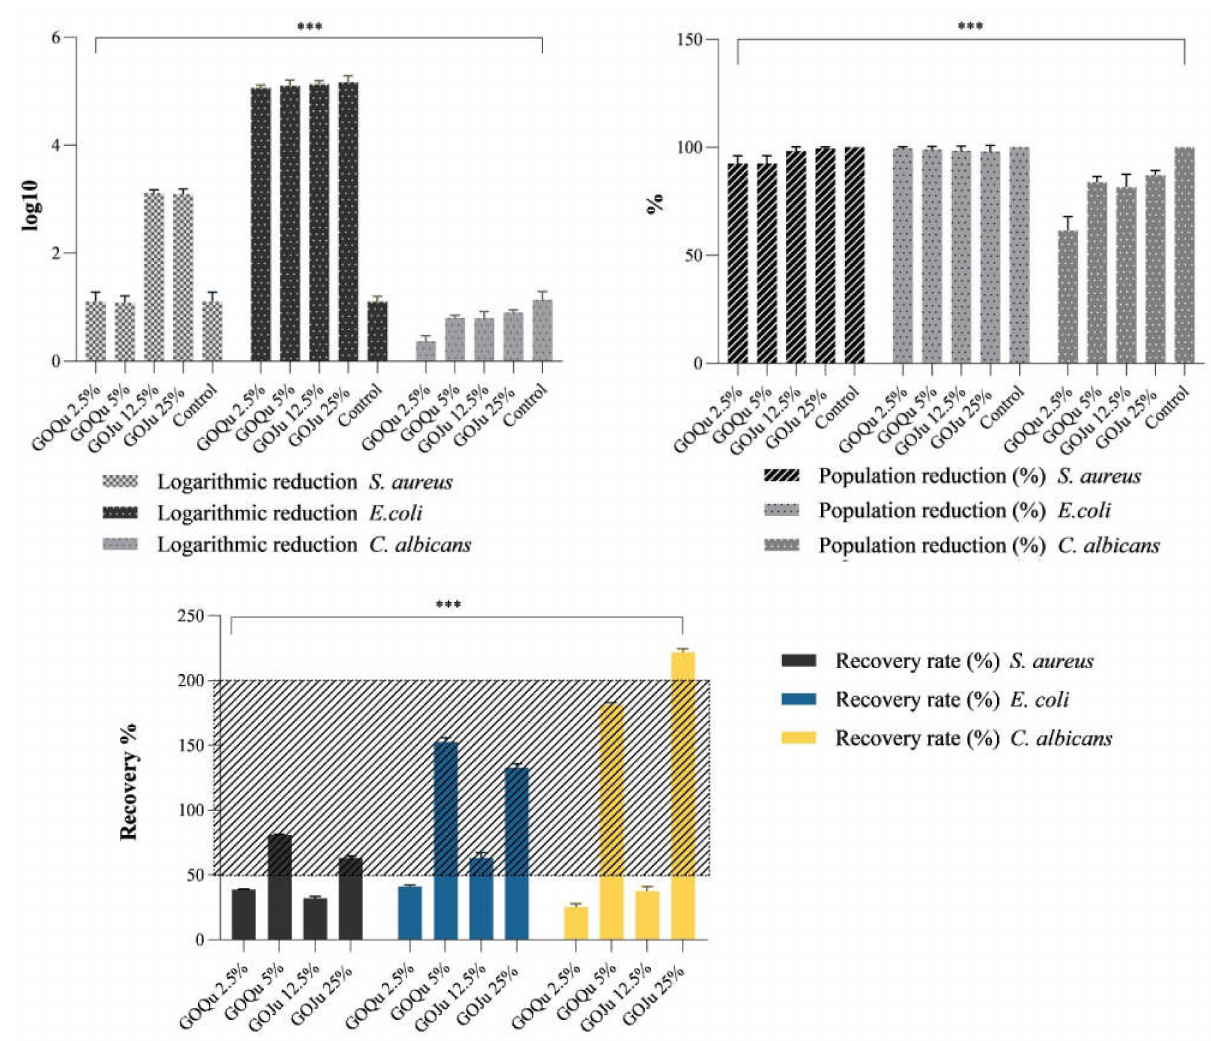
Figure 8. Logarithmic reduction, population reduction, and recovery rate of S. aureus ATCC, E. coli ATCC, and C. albicans ATCC strains by samples GOQu 5% ( w / v ), GOQu 2.5% ( w / v ), GOJu 10% ( w / v ), and GOJu 5% ( w / v ). Control is represented by microbial strains with no treatment; p -value < 0.002